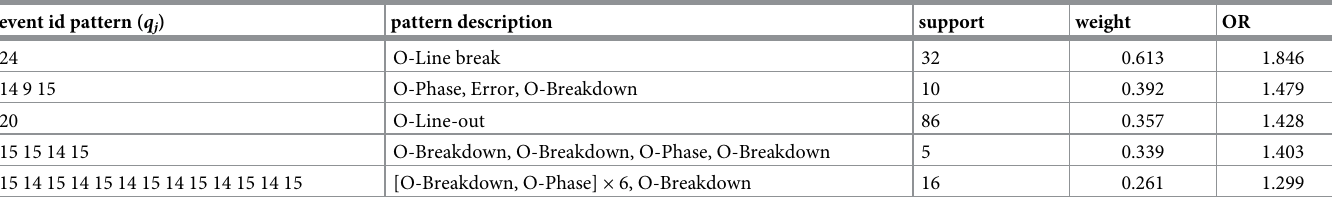
Table 6. Top five SPP-obtained patterns that discriminated the most between conceding and non-conceding outcomes. event id pattern ( q j